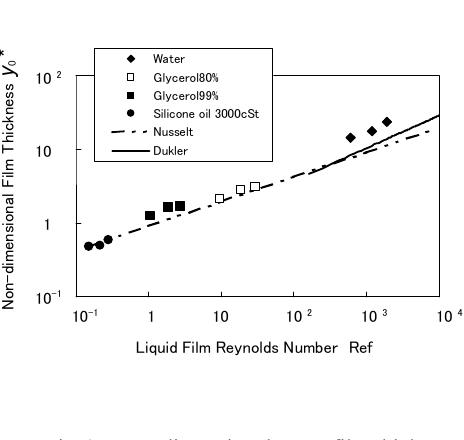
Fig.6 Non-dimensional mean film thickness and liquid film Reynolds number